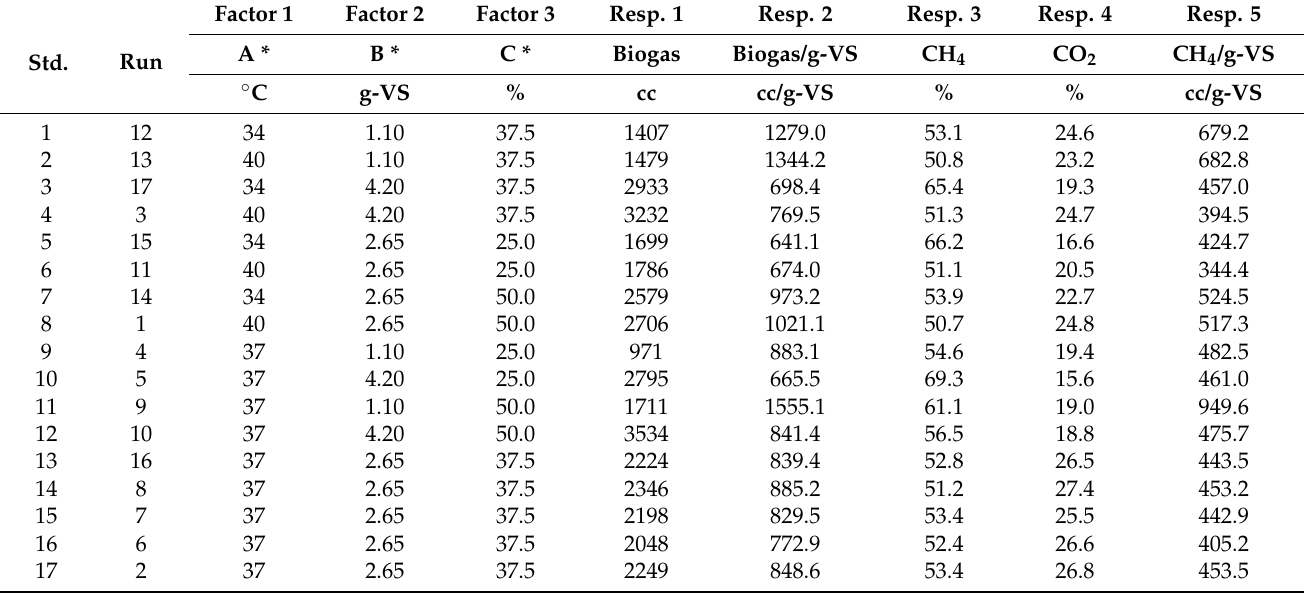
Table 8. The Experiment